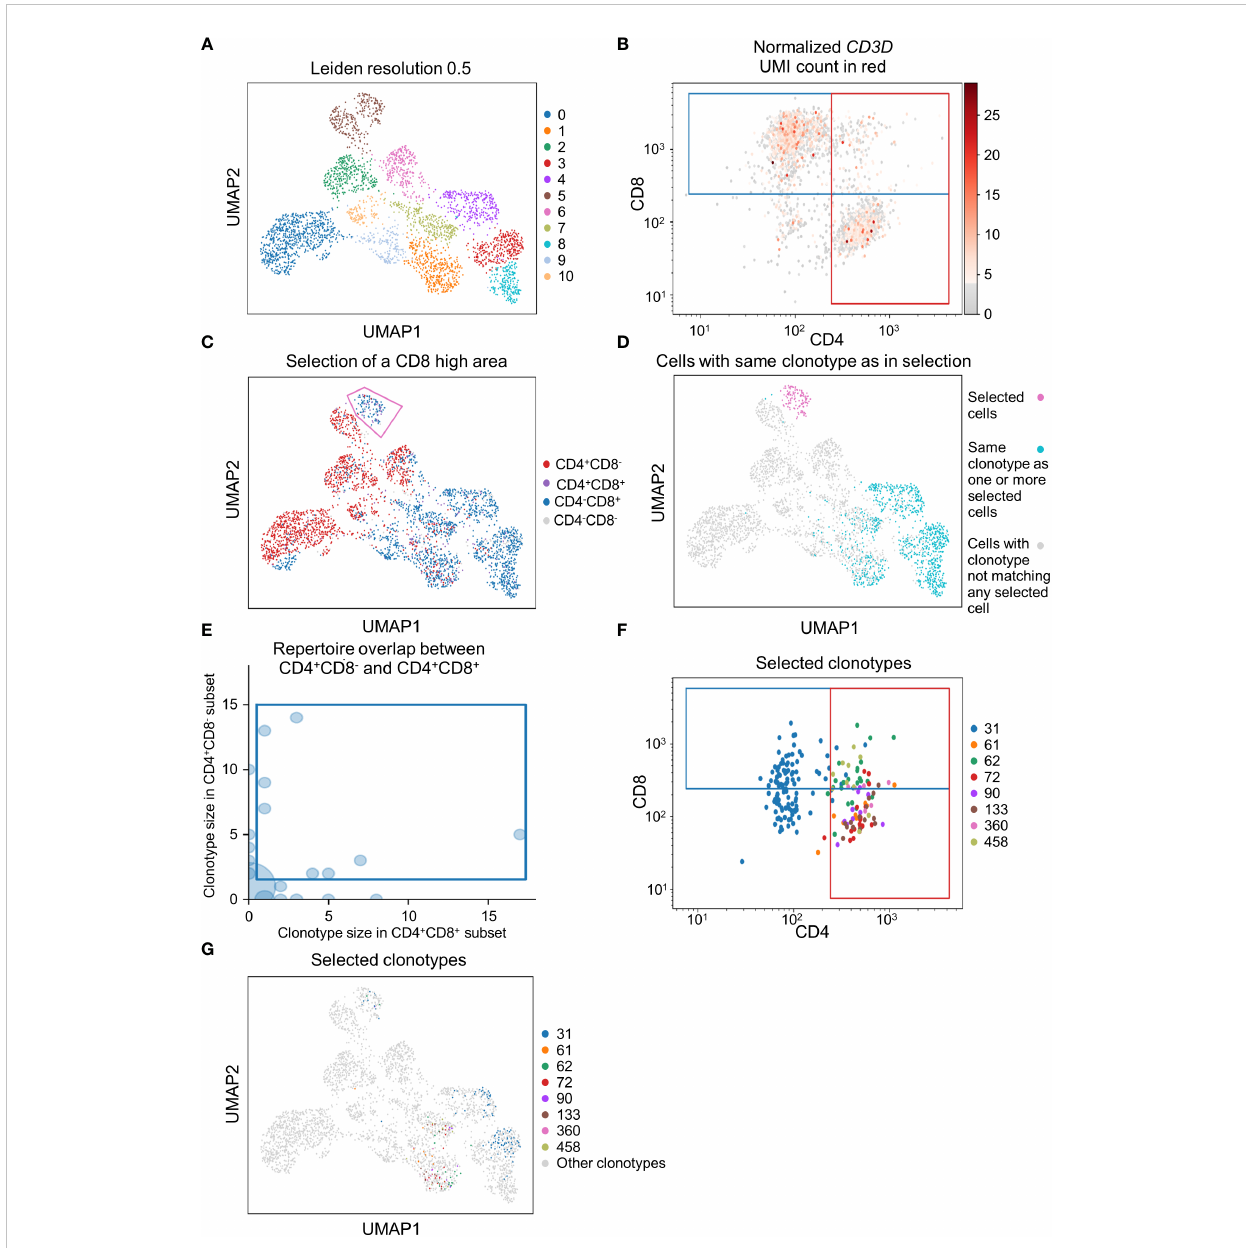
FIGURE 5 Applying scSELpy on T cell receptor (TCR) sequencing and antibody capture data. The single cell RNA sequencing data of PBMCs in blood from patients treated with Immune checkpoint inhibitors was retrieved from GSM6346300. Only cells, for which a TCR is detected are used in these plots. (A) UMAP plot of the cells; clusters are de fi ned by leiden with a resolution of 0.5. (B) Scatter plot with the detected CD4 and CD8 antibody UMIs on the x-axis and y-axis, respectively. Gates set with scSELpy split the data up into CD4 + CD8 + double positive cells, single positive CD4 + CD8 - cells, single positive CD4 - CD8 + cells and CD4 - CD8 - double negative cells. The CD3D mRNA derived UMI count is highlighted in red. (C) Visualization of the four groups de fi ned in (A) on the UMAP plot. A group of cells is selected with scSELpy. (D) UMAP representation of T cells selected in (C) (magenta) together with all other T cells also expressing one of the TCRs present in the selection (blue). Cells colored in grey do not have a clonotype that matches a T cell in the selected region. (E) TCR repertoire of CD4 + CD8 - cells plotted against TCR repertoire of CD4 + CD8 + cells for each clone ID using Scirpy. Clone IDs that are present in both cell populations were selected using scSELpy. (F) Mapping of the cells selected in (E) on the scatter plot of CD4 and CD8 antibody UMIs with the gates kept as in (B) . (G) UMAP representation of the T cells selected in (E)